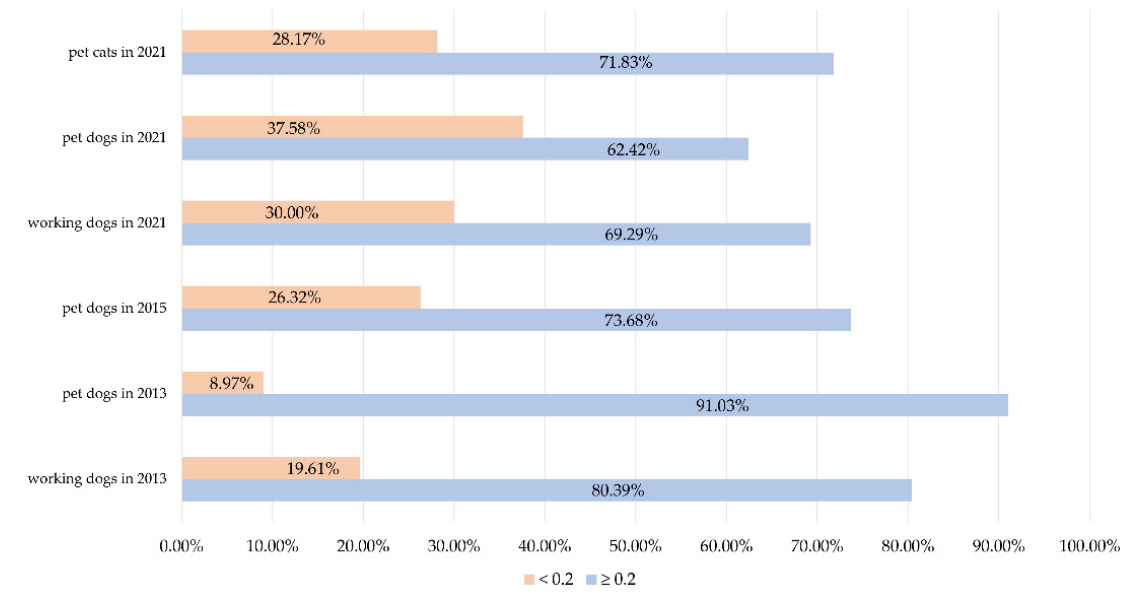
Figure 1. MAR index of E. coli of different origins and years.